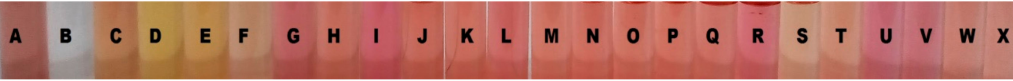
Figure 7. Color change in the solutions of receptor 1 in water (pH = 7.6, 1.0 mM HEPES) upon addition of acetate salts of various metal ions. [ 1 ] = 20 µ M. From left to right, A = Free, B = Hg 2 + , C = Al 3 + , D = Cr 3 + , E = Fe 3 + , F = Cu 2 + , G = Rb + , H = Sm 3 + , I = Zn 2 + , J = K + , K = Gd 3 + , L = Pb 2 + , M = Ca 2 + , N = Ni 2 + , O = Cd 2 + , P = Fe 2 + , Q = Mg 2 + , R = Pd 2 + , S = Na + , T = Cs + , U = Li + , V = Ba 2 + , W = Co 2 + , X = Sr 2 +